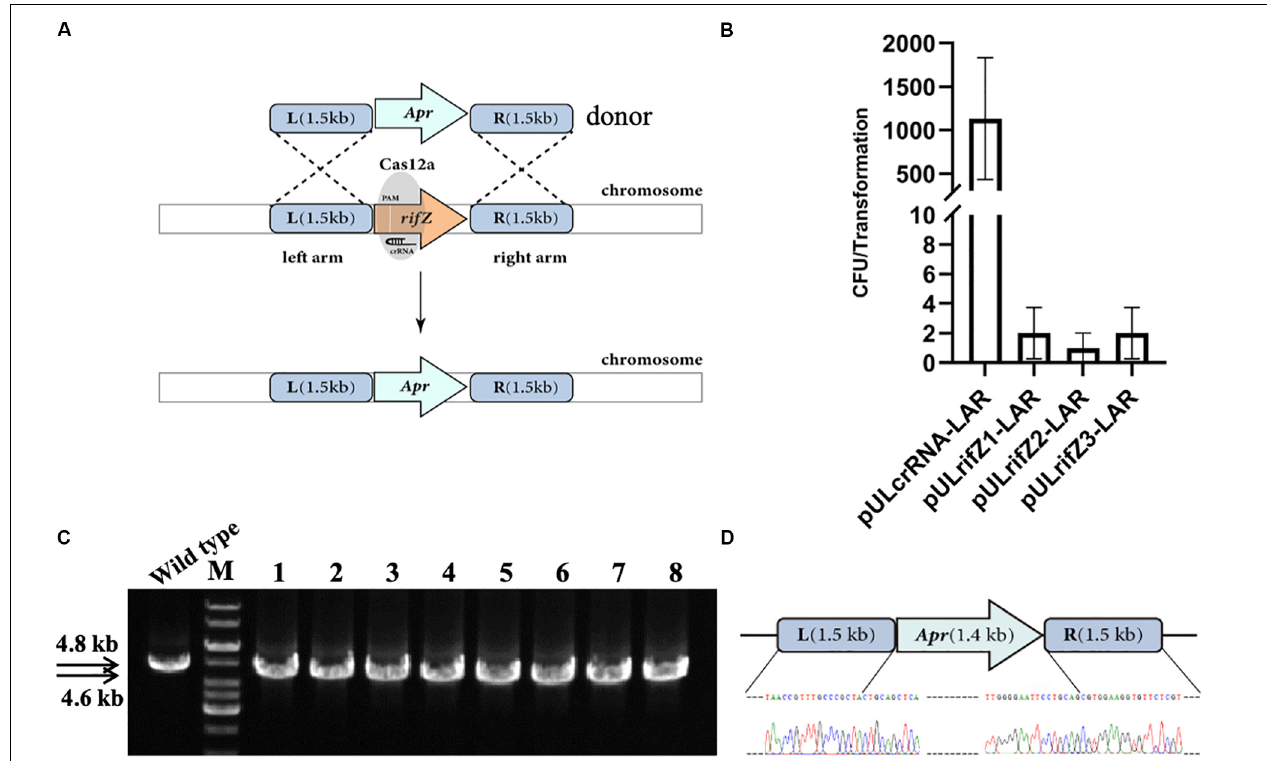
FIGURE 3 | Replacement of rifZ by an antibiotic cassette with CRISPR-Cas12a-assisted precise cutting and HDR-mediated precise recombination in A. mediterranei U32. (A) Schematic of rifZ deletion. With the existence of a crRNA targeting rifZ , Cas12a introduced DSBs within rifZ gene, which could then be precisely repaired by a donor DNA fragment containing an apramycin resistance cassette and the flanking upstream and downstream homologous sequences. (B) The number of transformants obtained with three different crRNAs targeting different loci within rifZ . Plasmid pULcrRNA, which contained no crRNA guide sequences, was employed as a control plasmid. The data were obtained from three independent transformation experiments. (C) PCR amplification analysis of rifZ mutant with paired primers of rifZ -KO-F and rifZ -KO-R. The amplicon of the wild type was 4.8 kb in length, while was smaller in rifZ mutants. M, GeneRuler 1 kb DNA Ladder (Thermo Scientific); lanes 1 and 2, colonies obtained with pUL rifZ 1-LAR; lanes 3 and 4, colonies obtained with pUL rifZ 2-LAR; lanes 5–8, colonies obtained with pUL rifZ 3-LAR. (D) Sanger sequencing results of the amplicon from Figure 3C . All eight amplicons were sequenced and found to be correct, and only the results of the first colony were